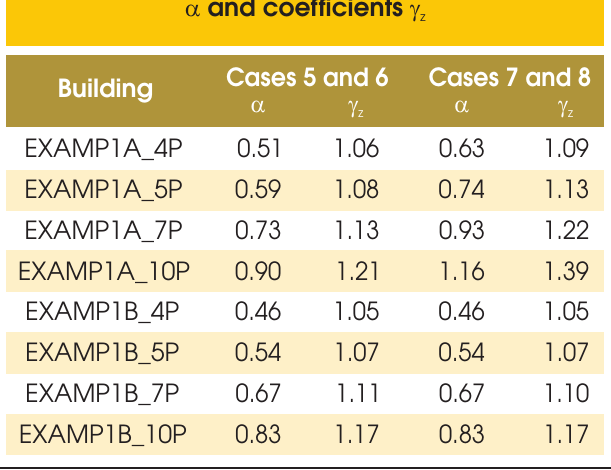
Table 12 – Comparison of